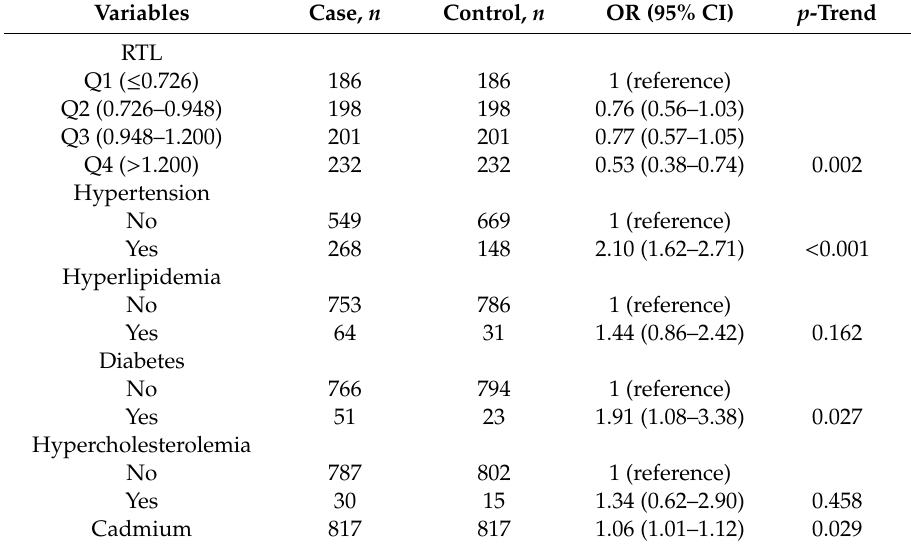
Table 2. Conditional Logistic Regression Analysis of the Correlations of Hearing Loss.